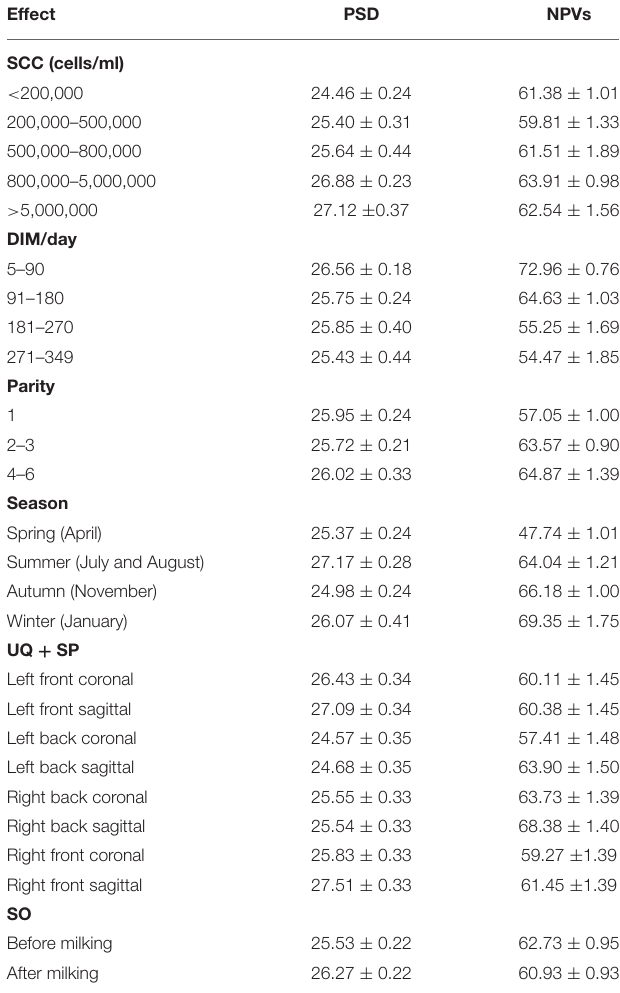
TABLE 1 | Factors affecting the echotextural characteristics of mammary gland parenchyma (NPVs and PSD).